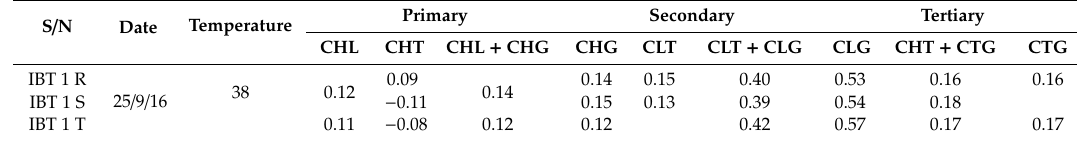
Figure A1. Typical loading profile for IBT in 2016. Figure D1. Typical loading profile for IBT in 2016. Table A6. Winding Tan Delta / Dissipation factor. Table D2. Winding Tan Delta/Dissipation factor.